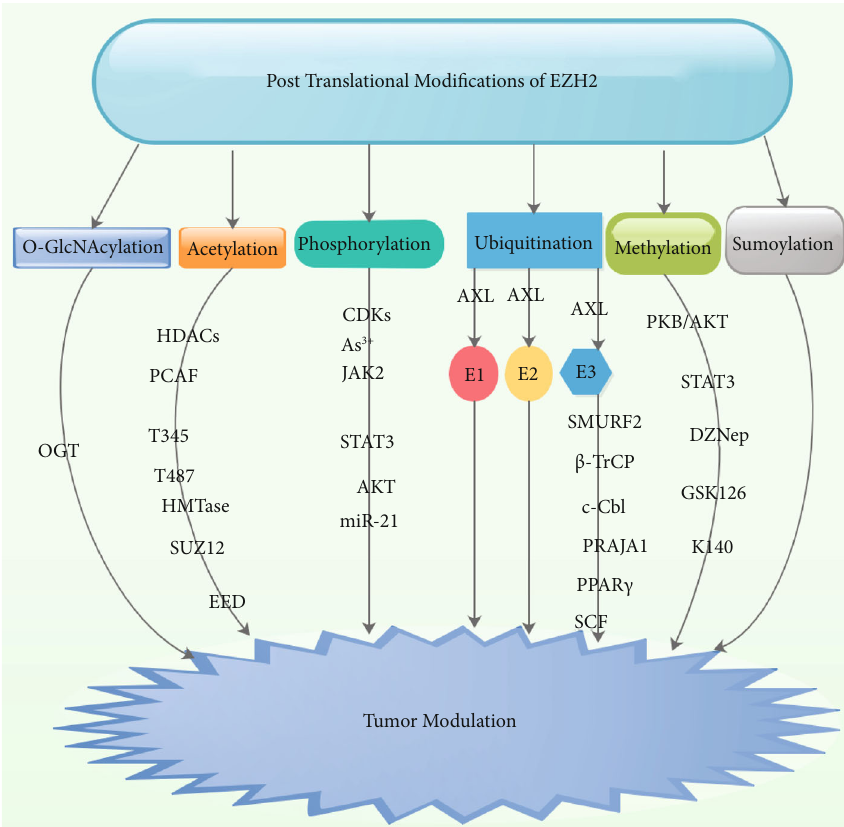
Figure 1: The posttranslational modi fi cations of EZH2 and